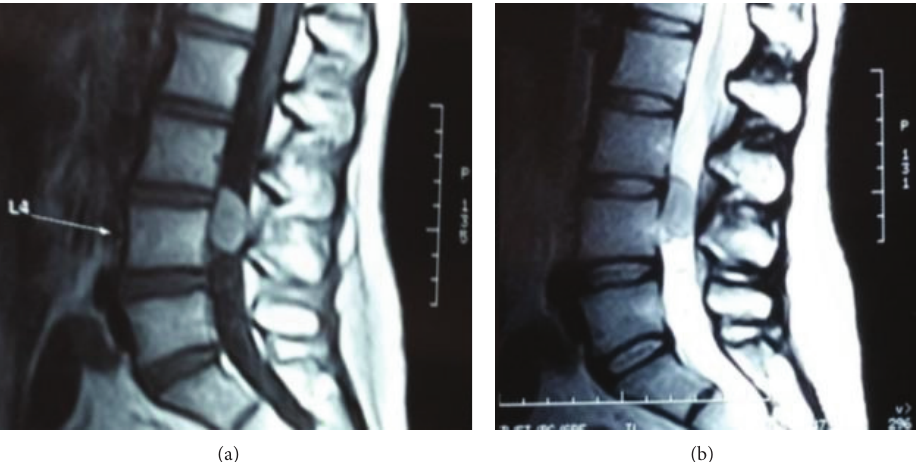
Figure 1: MRI of the lumbar spine showing a hyperintense (T1 weighted images (a)) and hypointense (T2 weighted images (b)) intracanalar tumor on the posterior aspect of the L3-L4